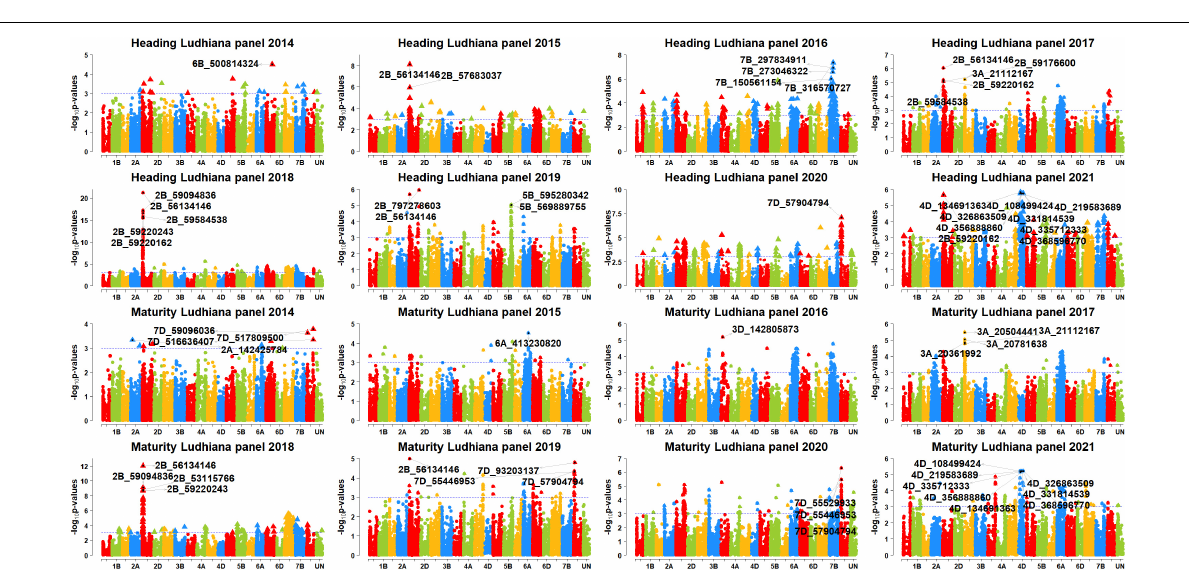
FIGURE 5 | Manhattan plots showing the genomic regions significantly associated with days to heading (DH) and maturity (DM) in Ludhiana in panels